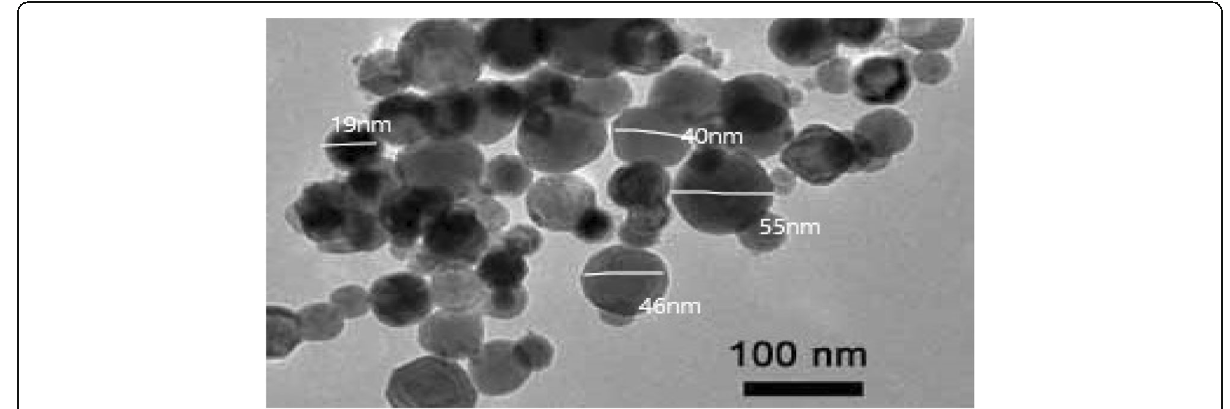
Fig. 2 TEM analysis of banana peel extract using alkaline